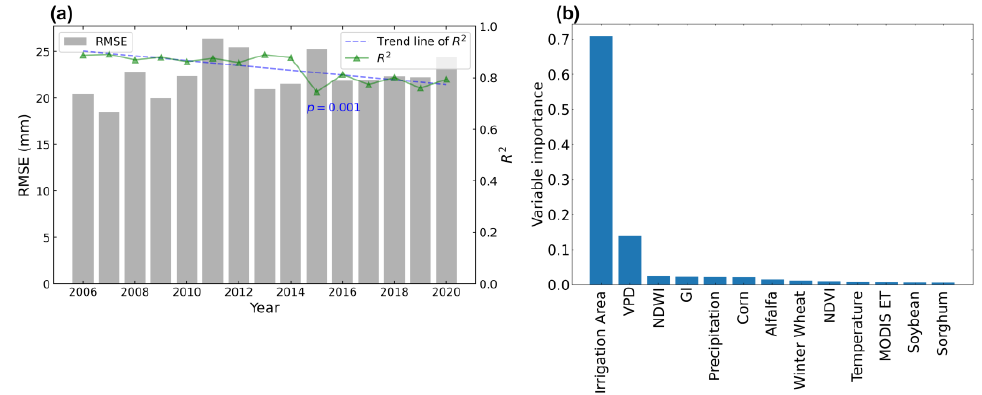
Figure 3. Results from Experiment A (random split), including ( a ) annual root-mean-square error (RMSE) and coefficient of determination ( 𝑅 2 ) from 2006 to 2020; Linear regression of 𝑅 2 shows a statistically significant declining trend ( 𝑝 = 0.001 ); ( b ) Random forest variable importance scores.